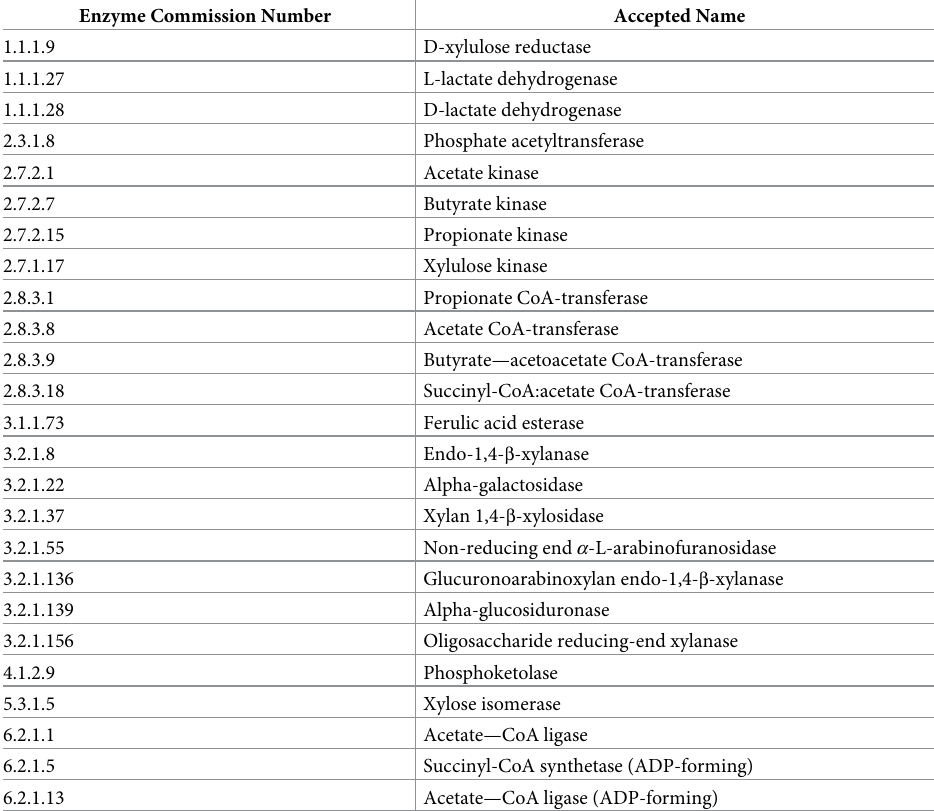
Table 1. Enzymes associated with arabinoxylan degradation, pentose metabolism, or short chain fatty acid pro- duction that were selected for gene prediction-based analysis using Phylogenetic Investigation of Communities by Reconstruction of Unobserved